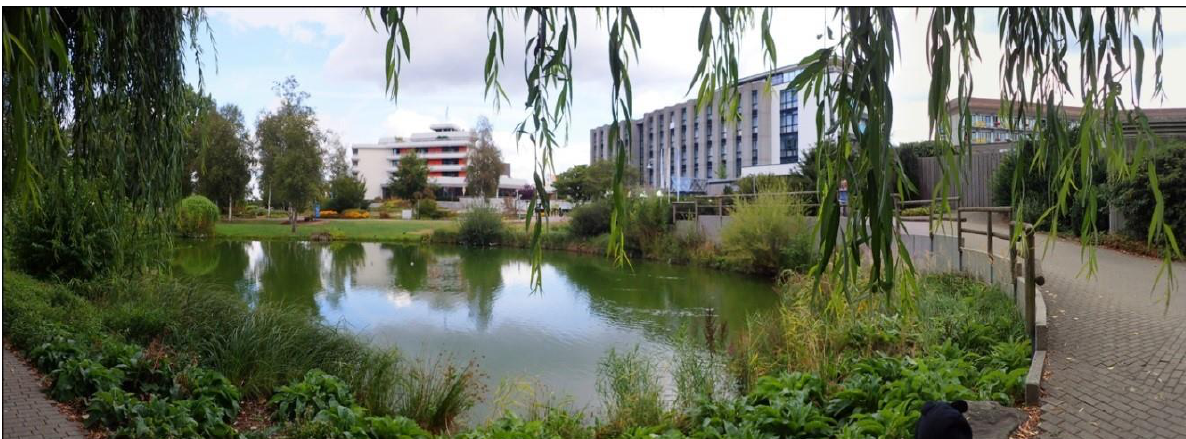
Figure 1. The primary health resort space of Bad Buchau – a complex of rehabilitation clinics against the background of a lake, which is an element of the health resort park b. Bad Saulgau, located only around a dozen kilometres away from Bad Buchau, is significantly larger. The health resort is located in the western part of the downtown area (Figure 2), at a distance of around 1 kilometre. It is also spatially separated from the old town's structure. In the health resort zone we can distinguish three functional sections: rehabilitation clinics, a complex of thermal baths with a medicinal and recreational function, as well as a park that integrates the entire complex. The health resort's park layout is a particularly significant attraction. It was designed in the form of a contemporary garden, whose composition is based around a shallow canal that forms a longitudinal axis. The landscaped park greenery is closely tied with open areas that feature an education and walking